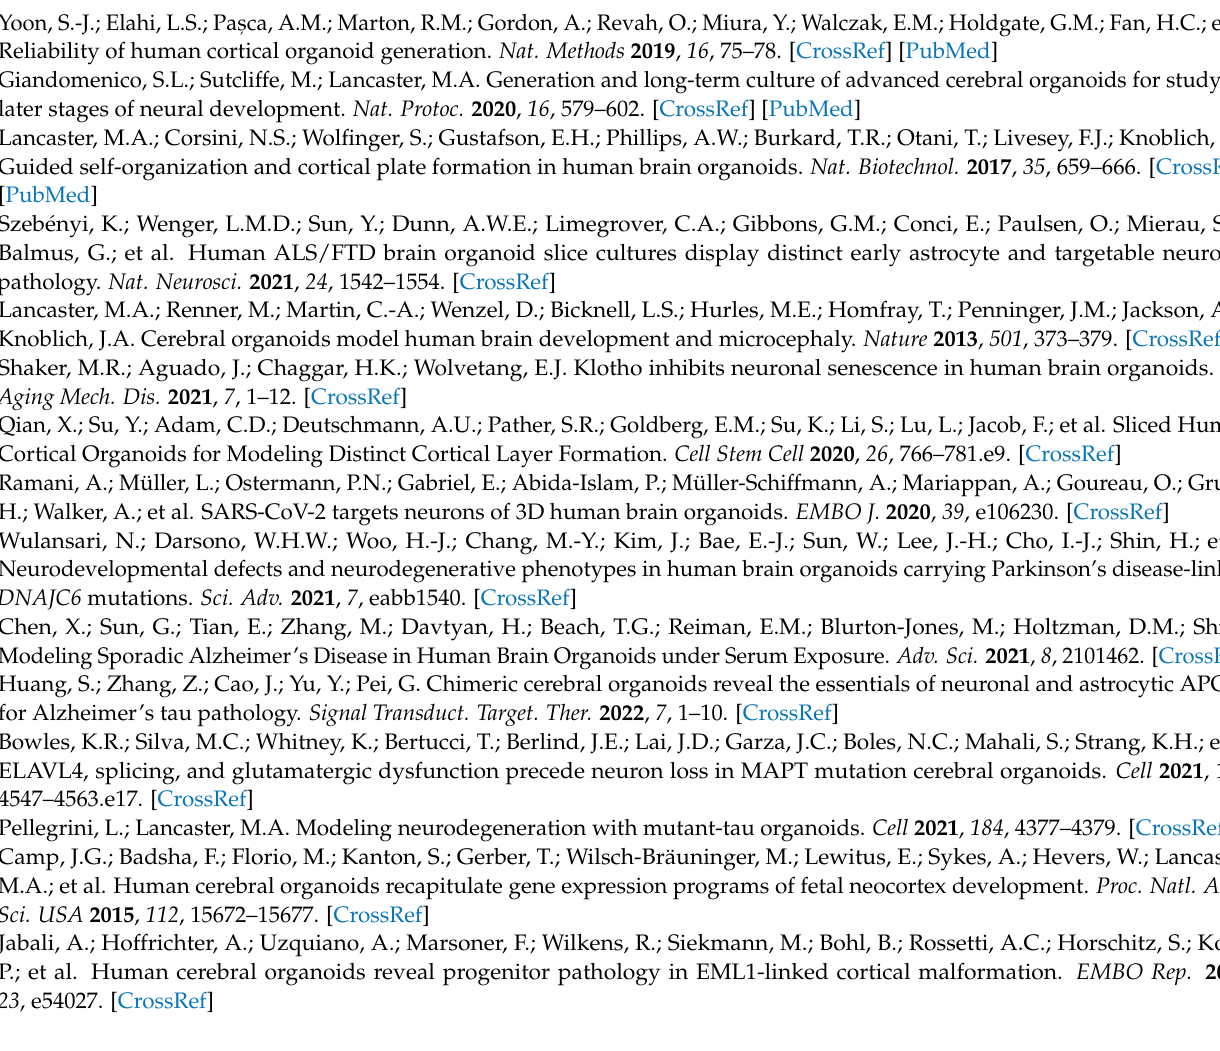
Figure S2: Immunostaining of cortical organoid; Figure S3: Gene expression profile of human cortical organoids; Figure S4: Other gene delivery methods tested in human cortical organoids; Figure S5: Optimization of AAV titer on cortical organoid; Figure S6: Toxicity in hCOs treated with